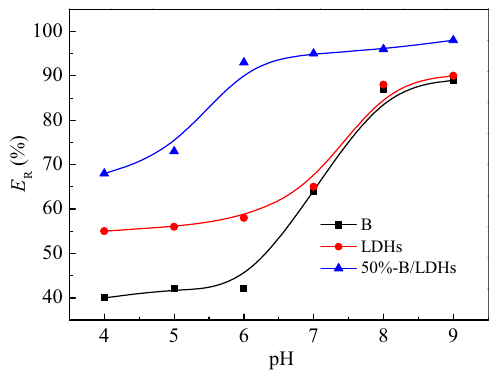
Figure 4: E ff ects of pH on the removal e ffi ciency of B, LDHs, and 50% B/LDHs for Pb ( II ) . C 0 = 50 mg/L, C s = 1.0 g/L, C NaNO and